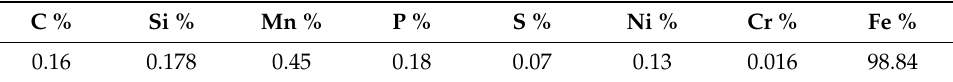
Table 6. Chemical composition of the structural steel.